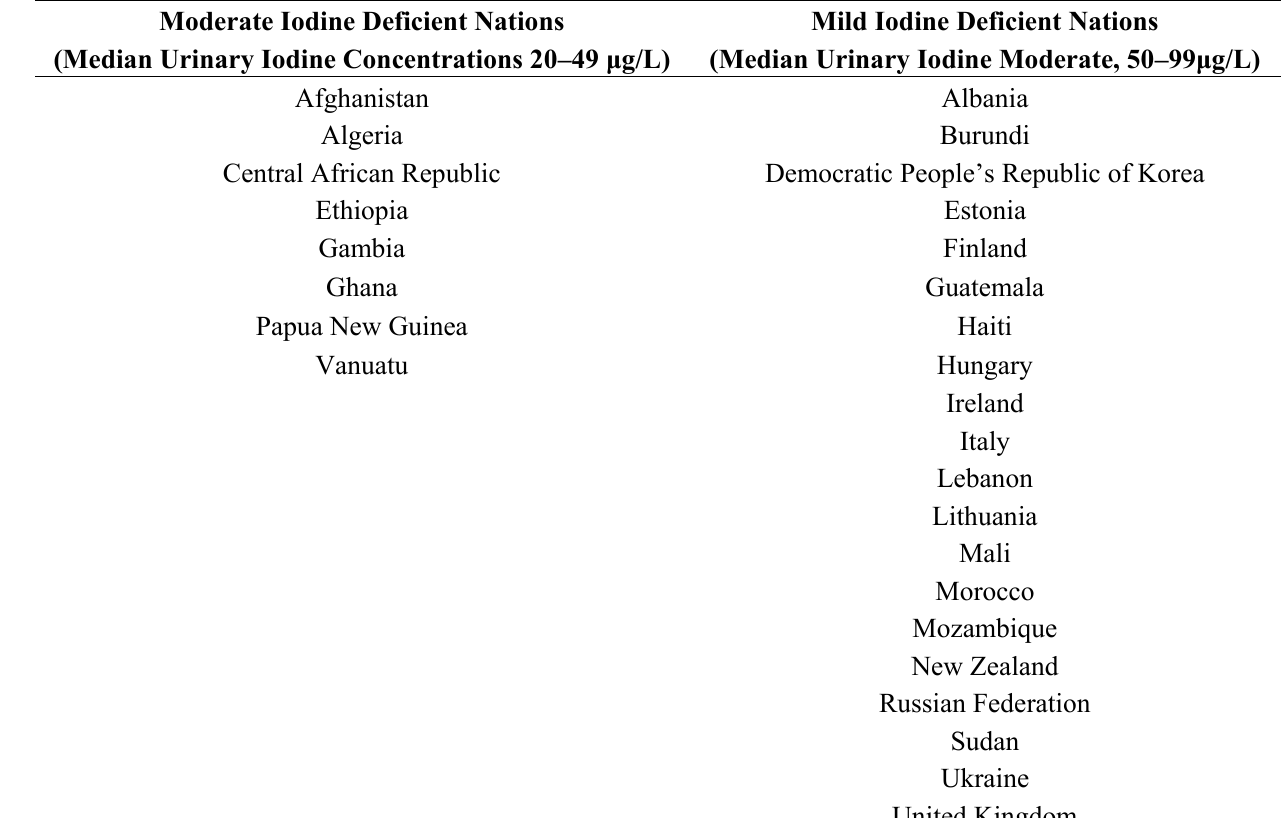
Table 9. Worldwide Iodine Deficiency in Urinary